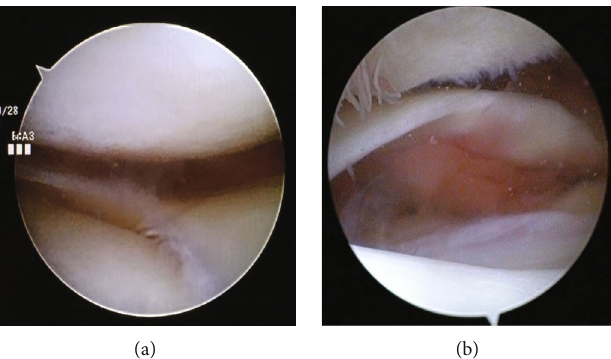
Figure 2: Arthroscopic view of the tibiofemoral joint: medial compartment (a) and lateral compartment (b).